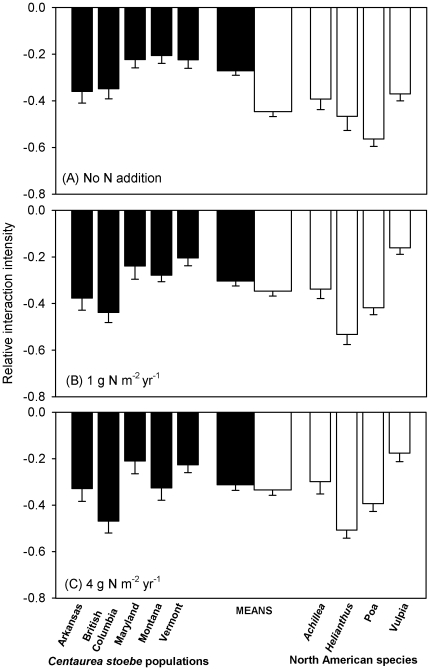
The mean competitive effects (means+1 SE), as indicated by relative interaction intensity (RII = (Bw−Bo)/(Bw+Bo)), of five Centaurea stoebe populations on four North American (NA) species (narrow black bars) and of four NA species on five C. stoebe populations (narrow white bars) under (A) no N addition, (B) low and (C) high N addition.Wide bars show means (+1 SE) for all five C. stoebe populations (black) or all four NA species (white). RII was calculated for each population under a given N level across four NA species, and Bw and Bo were the biomass of a plant of each of the four NA species in competition with a C. stoebe plant and the mean biomass of all the plants of each of the four NA species grown alone. RII was calculated for each NA species under a given N level across five C. stoebe populations, and Bw and Bo were the biomass of a plant of each of the five C. stoebe populations in competition with a NA plant and the mean biomass of all the plants of each of the five C. stoebe populations grown alone.